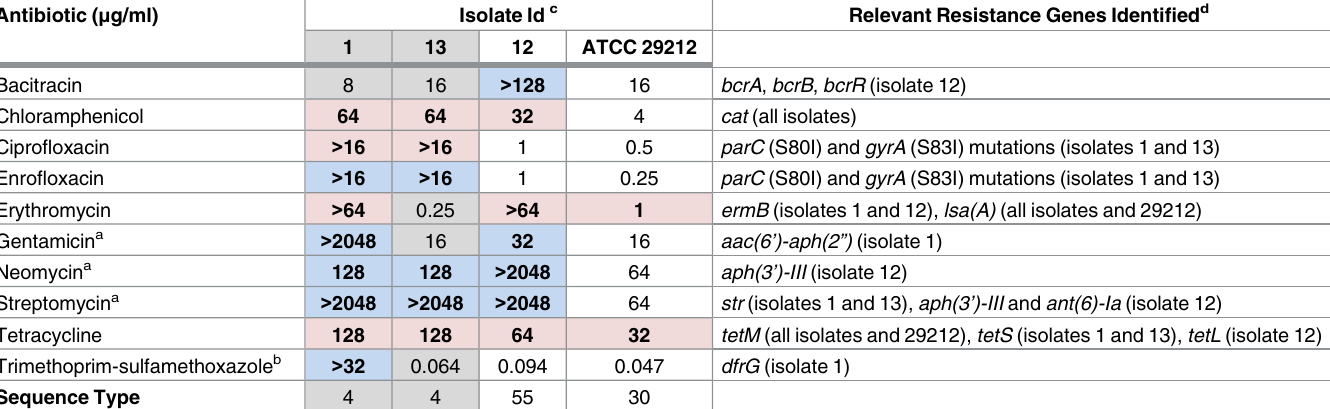
Table 6. Selected Antimicrobial Resistance MIC Results and Resistance Genes Identified from Whole Genome Sequence Data. Antibiotic ( μ